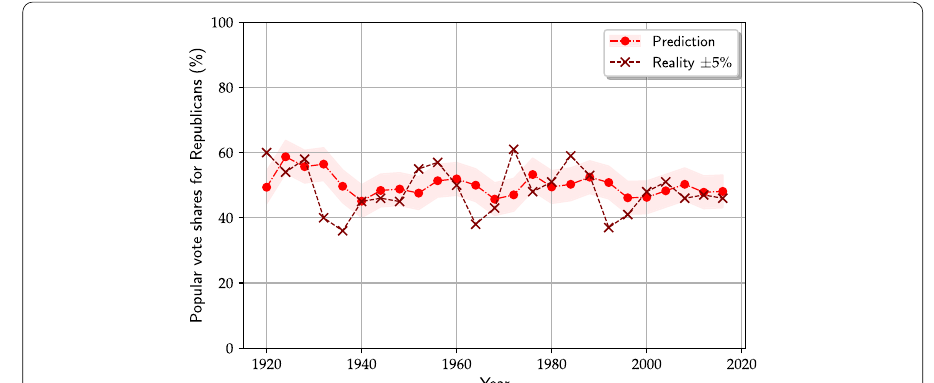
Fig. 4 Percentage of popular votes for Republicans in the US, prediction and reality. The shaded area covers a ± 5% deviation away from the predictions